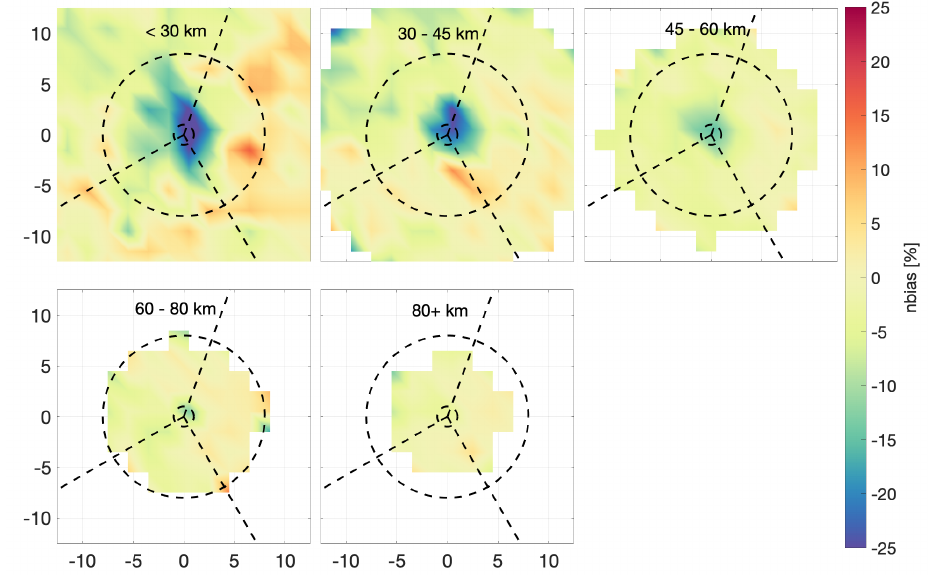
Figure 17. As in Figure 13, each subplot parsed by radius of maximum winds.